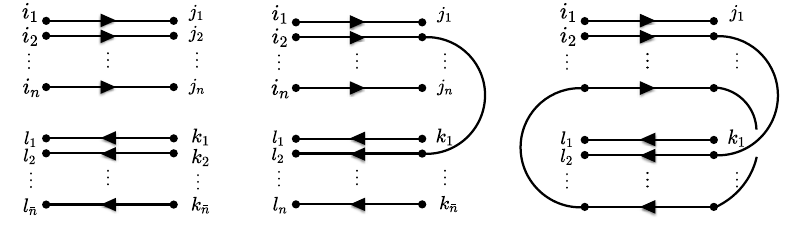
Figure 14 . On the left we have a diagram representing the states U middle represents constraints imposed on U IJ U y